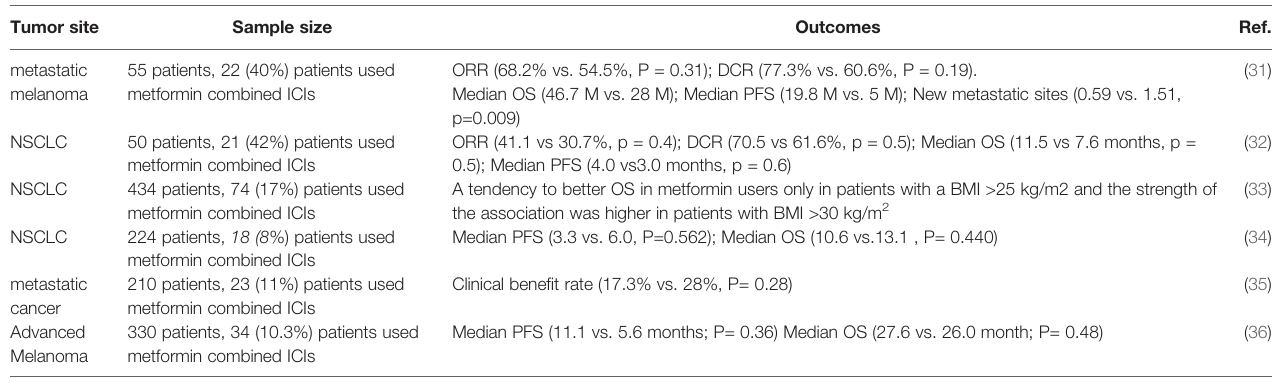
ORR, objective response rate; DCR, disease control rate; OR, overall survival; PFS, progression free